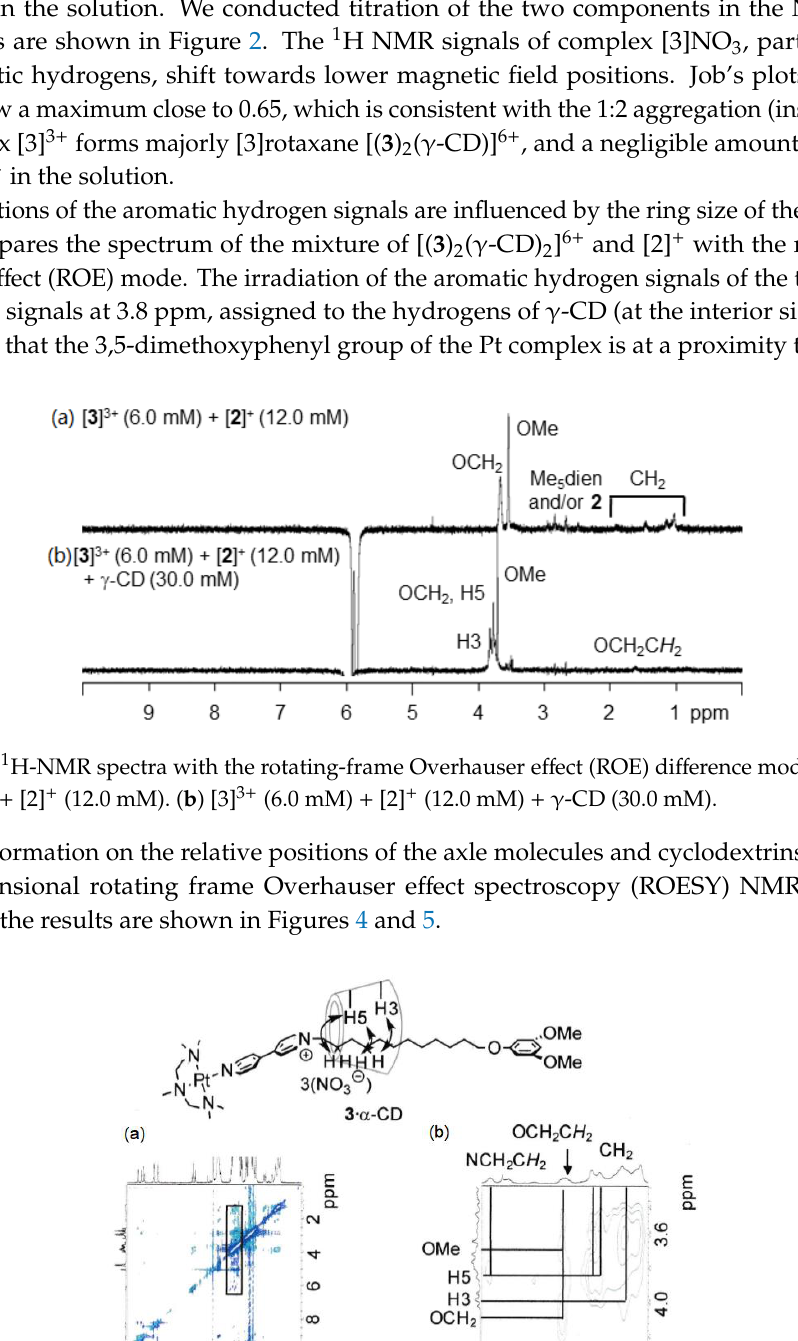
Figure 5. ROESY NMR spectra of [( 3 ) 2 · γ -CD] 6+ (D 2 O, 25 °C, 500 MHz). Total spectrum ( a ) and expanded spectrum ( b ). Figure 4(a), (b) present the cross peaks between the signals due to the CH 2 group hydrogens and the signals assigned to the interior hydrogens of α -CD (3.8 and 4.0 ppm) with high intensity. The NCH 2 hydrogens show significant correlation with the signals of α -CD. Considerably low-intensity cross-peaks are observed at the positions between the aromatic hydrogen signals of the terminal group of the ligand (e, f) and the interior hydrogens of α -CD. Thus, the rotaxane prefers the structure with the macrocyclic component ( α -CD) at proximity to the CH 2 hydrogens adjacent to the bipyridinium group. Another structure with the terminal 3,5-dimethylphenyl group and α -CD is also observed in a much smaller amount. Figure 5 shows the spectra of a mixture containing the rotaxane composed of the Pt complex and γ -CD. Clear correlation peaks are observed, indicative of the interaction between the cyclodextrin hydrogen and 3,5-dimethoxyphenyl hydrogens (e, f) and no cross-peak between the cyclodextrin and the CH 2 hydrogens. The ROESY NMR spectra of the rotaxane containing β -cyclodextrin also shows the cross-peak, indicative of the interaction between the aromatic hydrogens of the terminal group and the hydrogens of cyclodextrin.